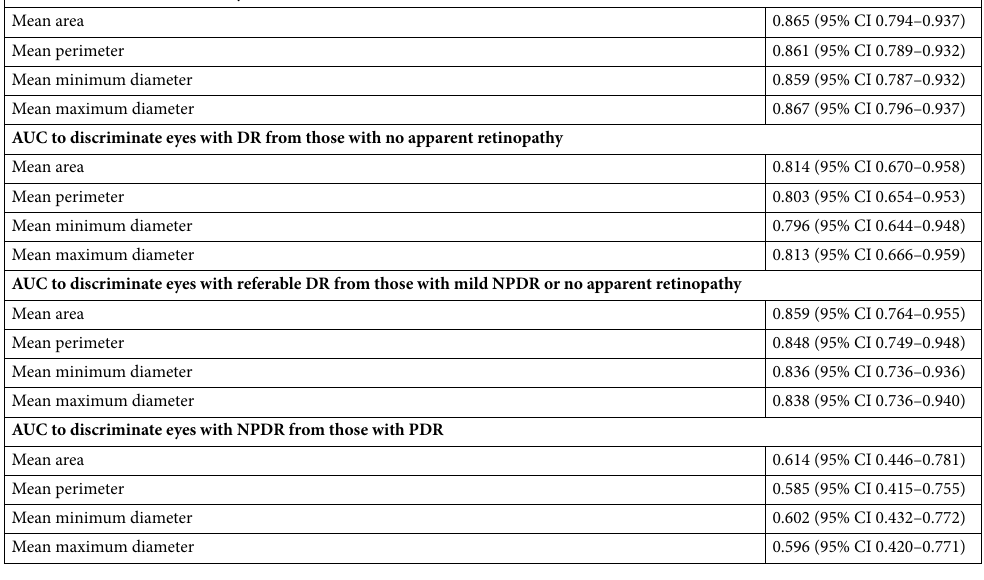
Table 2. The AUC of each